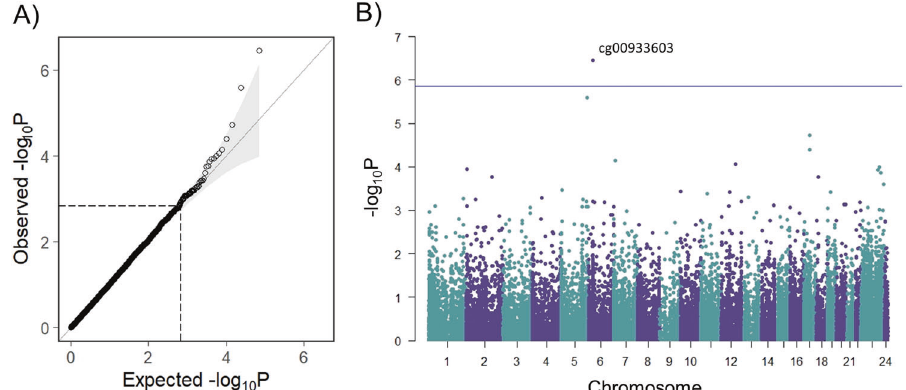
Fig. 3 PRS-strati fi ed EWAS in high-risk participants. A Quantile-Quantile plot, indicating observed vs. expected p values from 35,907 probes. Bias and in fl ation corrected to − 0.00049 and 1, respectively. The dashed line indicates the in fl ection point at p < 0.002. B Manhattan plot indicating the genomic location of differentially methylated probes. The vertical line indicates the multiple-testing correction threshold at α = 0.05 for epigenome-wide association, based on 35,907 probes ( p < 1.39 × 10 − 6 ). The location of the top DMP, cg00933603, is indicated. Covariates included age, sex, MDS C1 and C2, tissue source, six blood-cell components, and four surrogate variables. log logarithm; P p